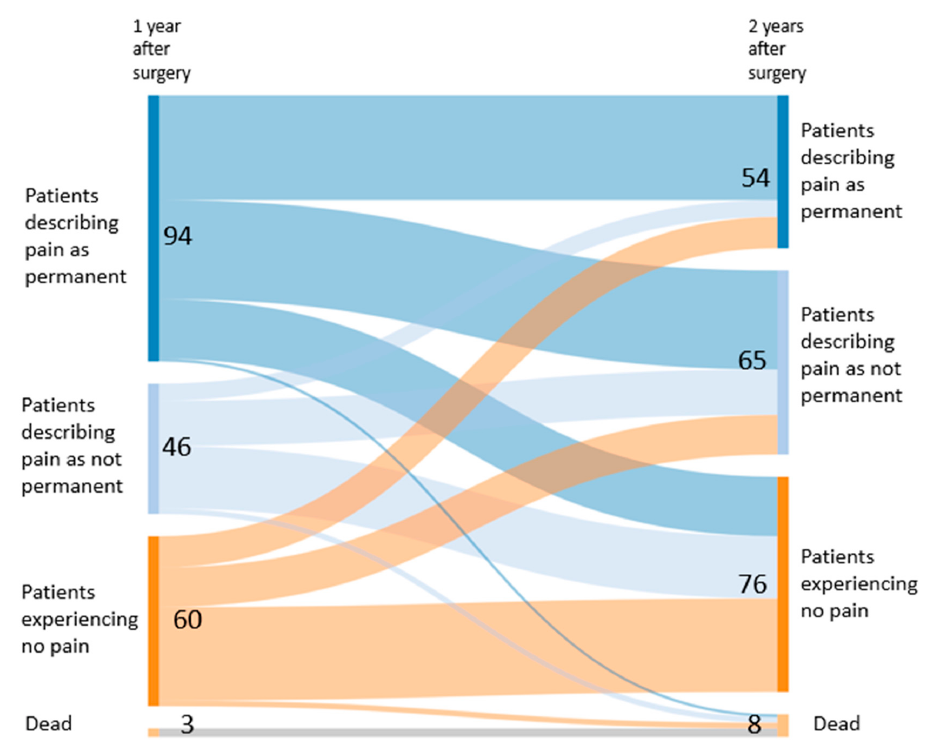
Figure 4. Pain permanence trajectories between the first and the second postoperative year.